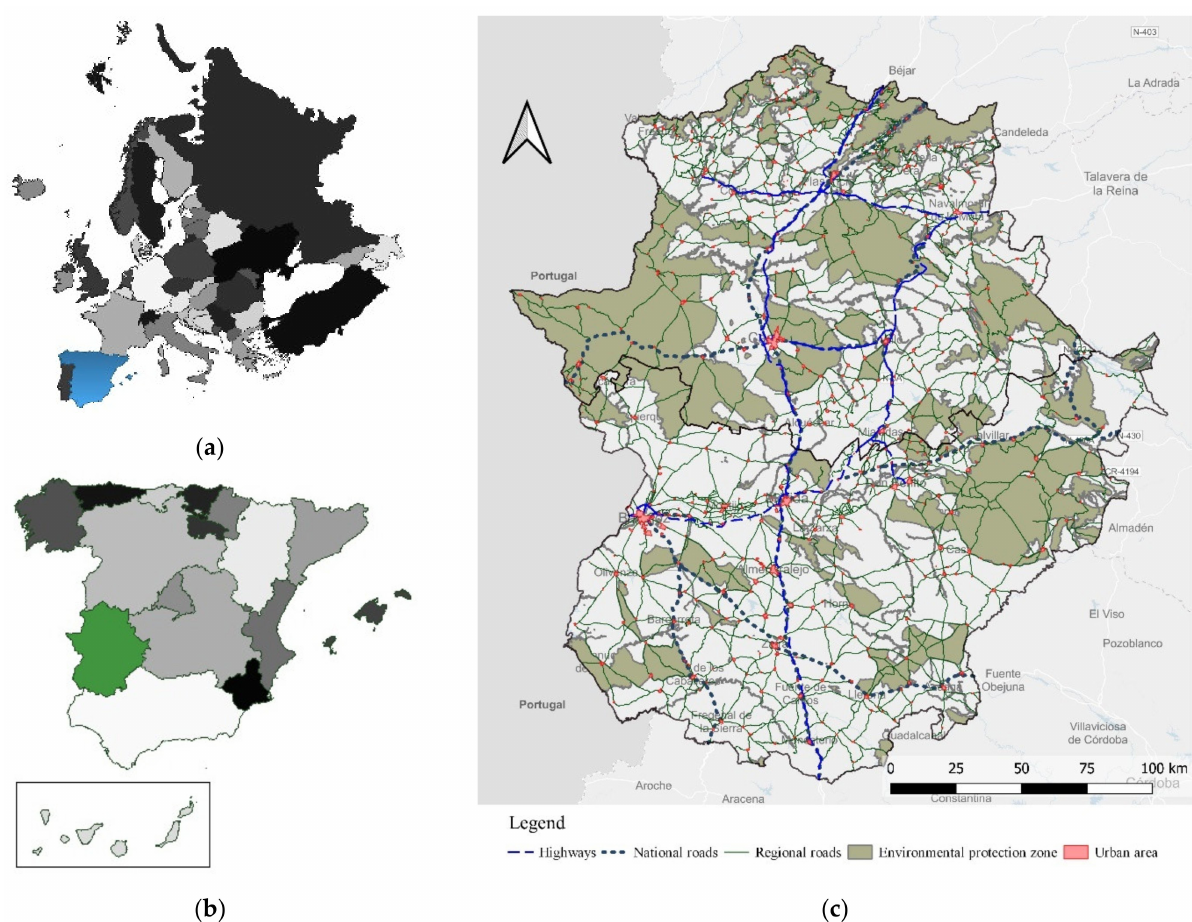
Figure 1. Spatial contextualisation of the study area. ( a ) Location of Spain (in blue) in Europe; ( b ) location of Extremadura (in green) in Spain; ( c ) map of Extremadura with communication routes and urban and environmental protected